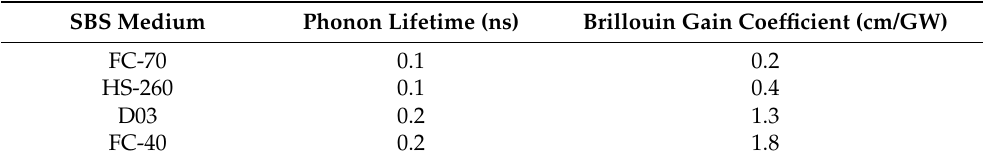
Table 2. Phonon lifetimes and Brillouin gain coefficients of different SBS media: FC-70, HS-260, D03, and FC-40.